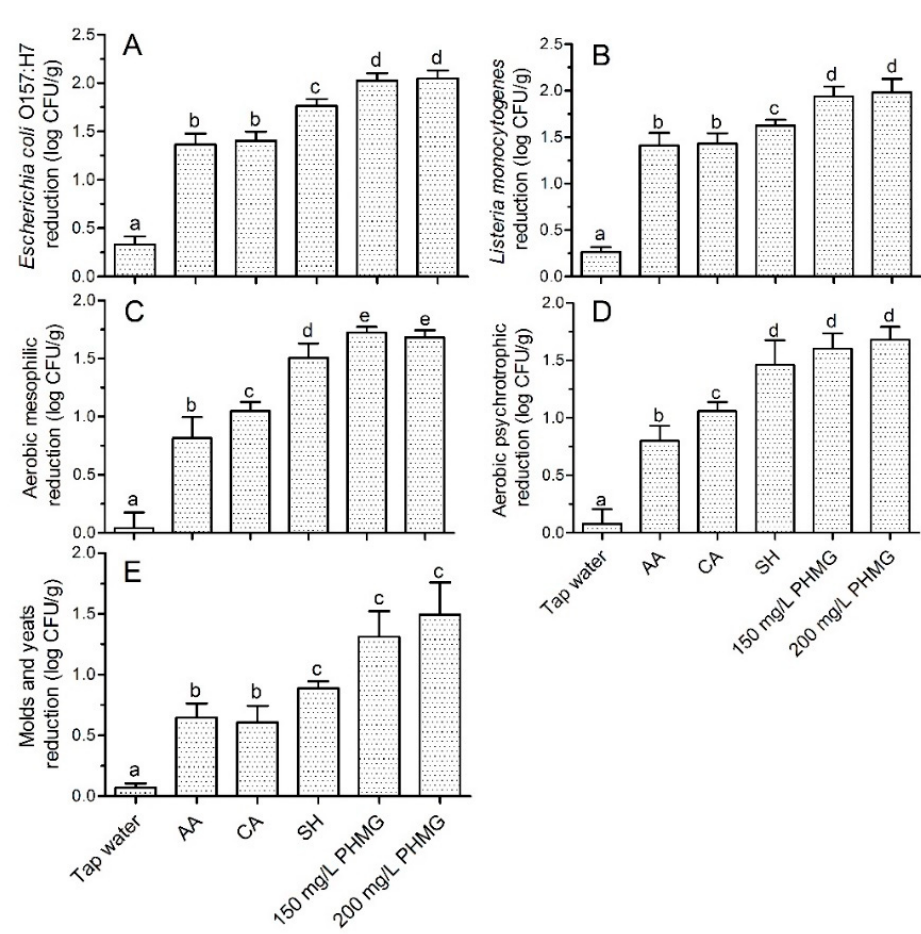
Figure 1. Microbial reduction (log CFU / g) of E. coli O157:H7 ( A ), L. monocytogenes ( B ), aerobic mesophilic counts ( C ), aerobic psychrotrophic counts ( D ), and molds and yeasts ( E ) present on ready-to-eat lettuce. Bars show means ± standard deviations, and different letters above the columns indicate significant differences ( p < 0.05). AA: acetic acid; CA: citric acid; SH: sodium hypochlorite.